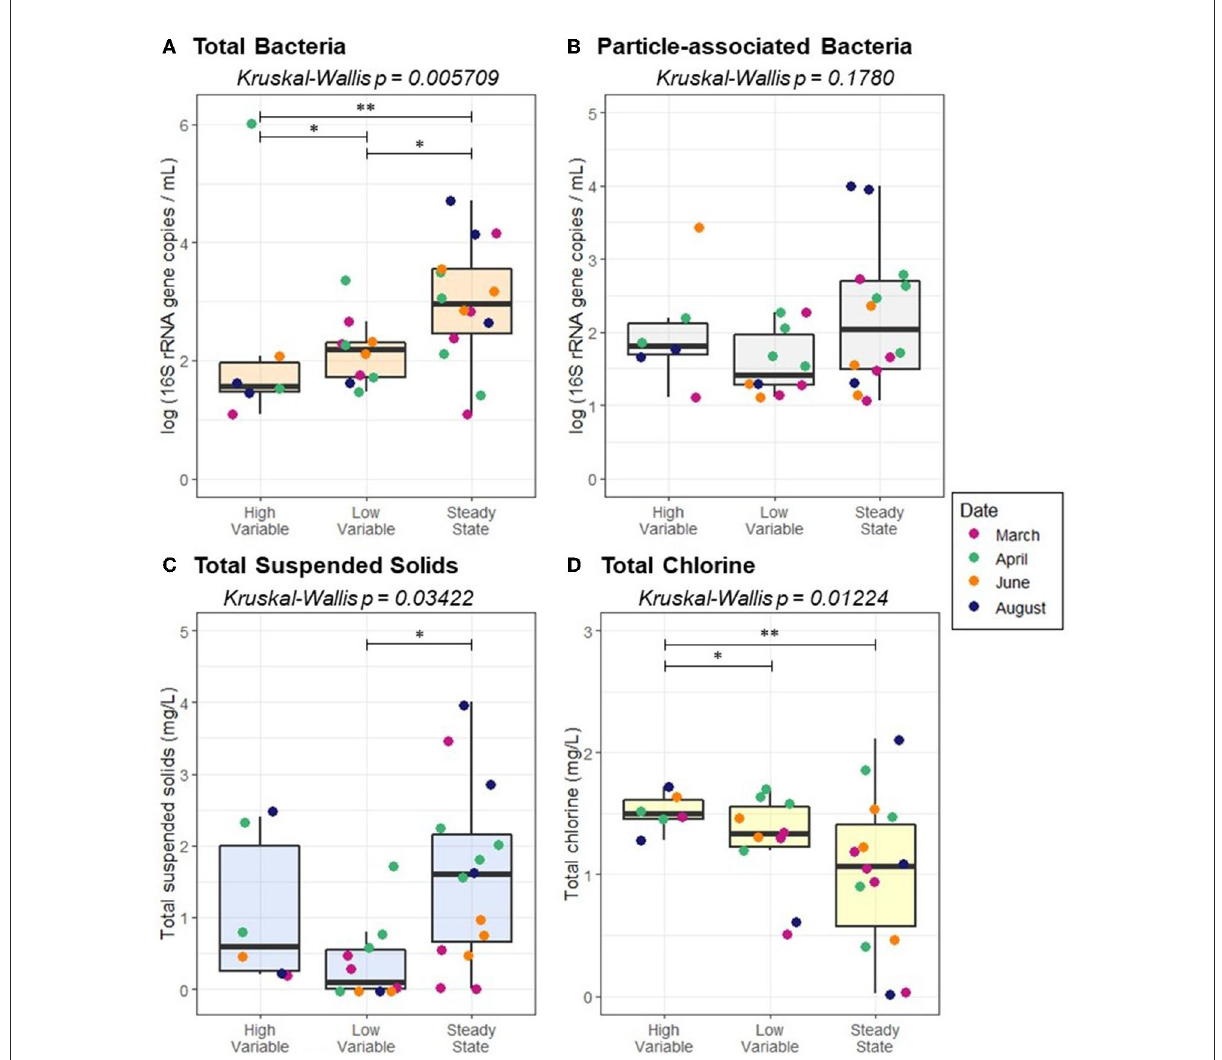
GC/mL (Supplementary Figure 7). For lower